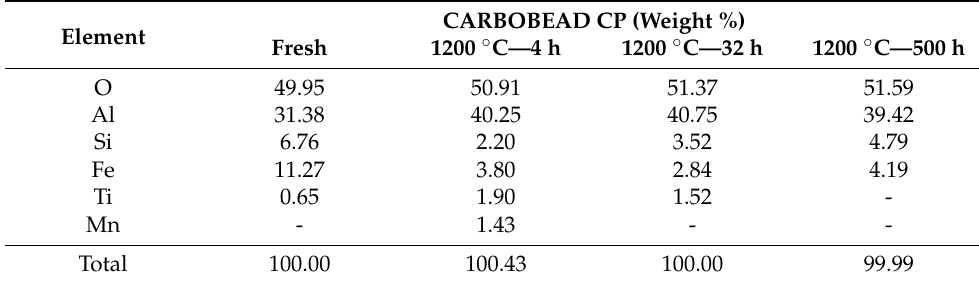
Table 6. Elemental composition of CARBOBEAD